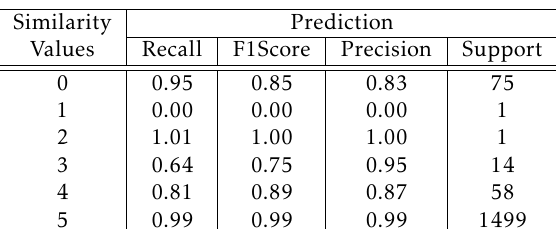
Figure 3. Loss curve. Table 1. Transitivity